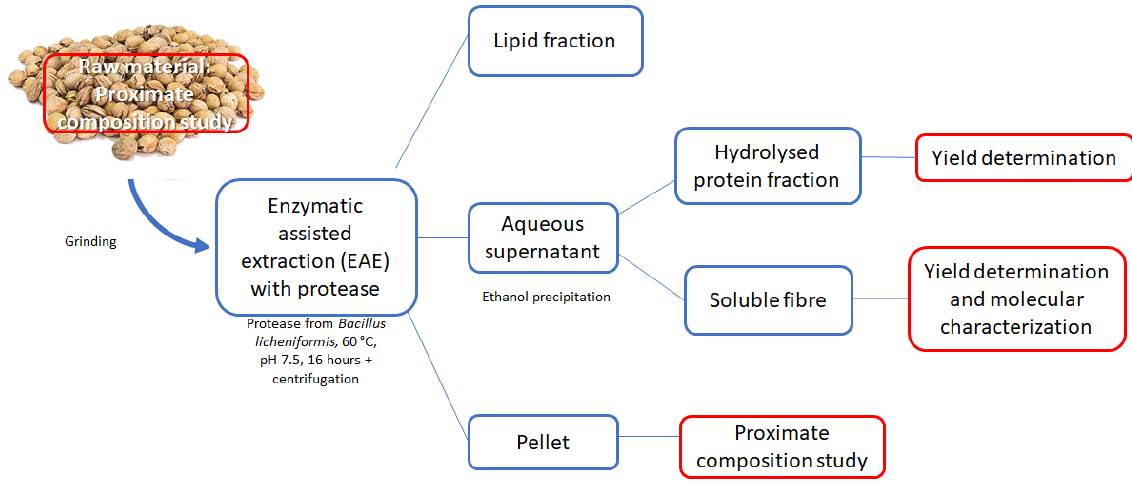
Figure 1. Representation of the fruit by-products one-step fractionation